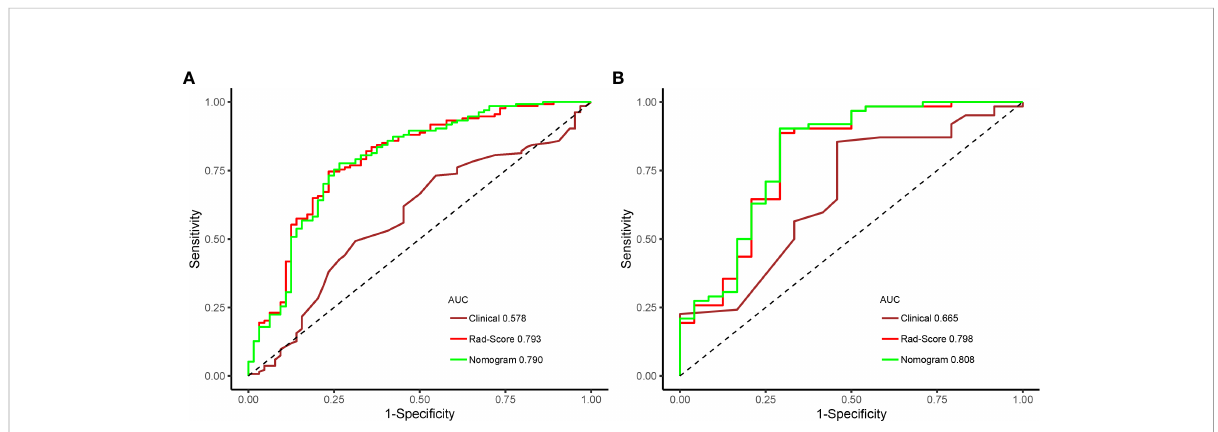
FIGURE 10 Receiver operating characteristic curves of the three models predicting the high Ki-67 expression in the training (A) and test sets (B) .